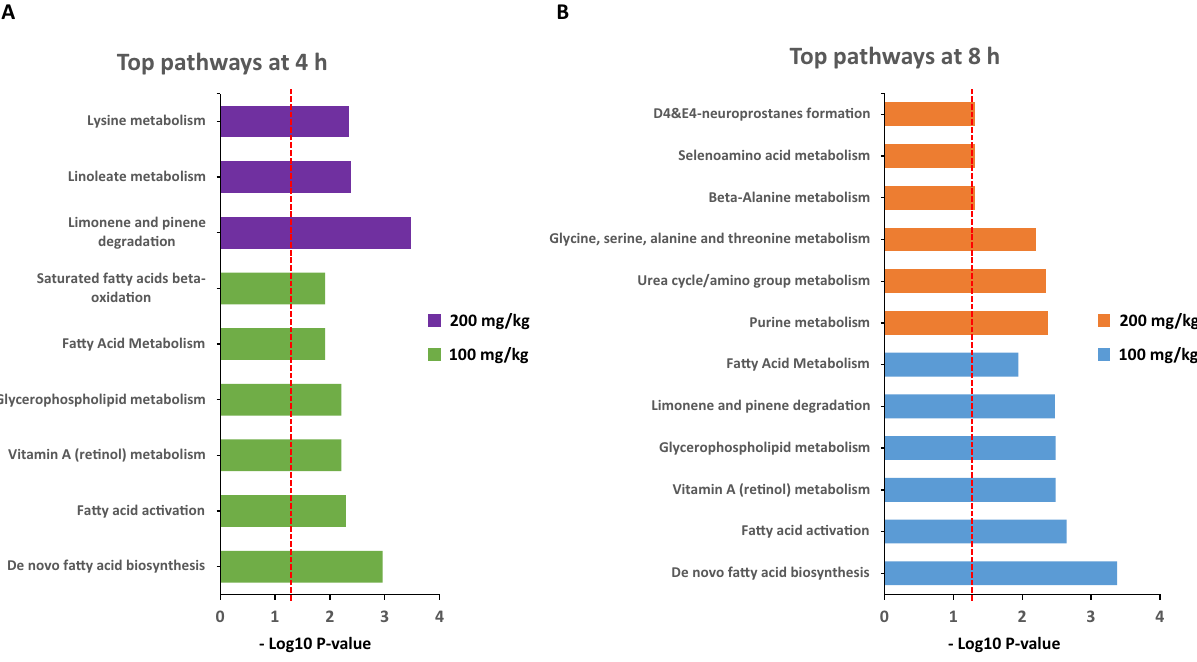
Figure 6. Pathway analysis as computed utilizing all detected features of both tested doses at the 4 h as well as the 8 h time points using Mummichog 2.06 software ( A and B ). The dotted lines denote the significance